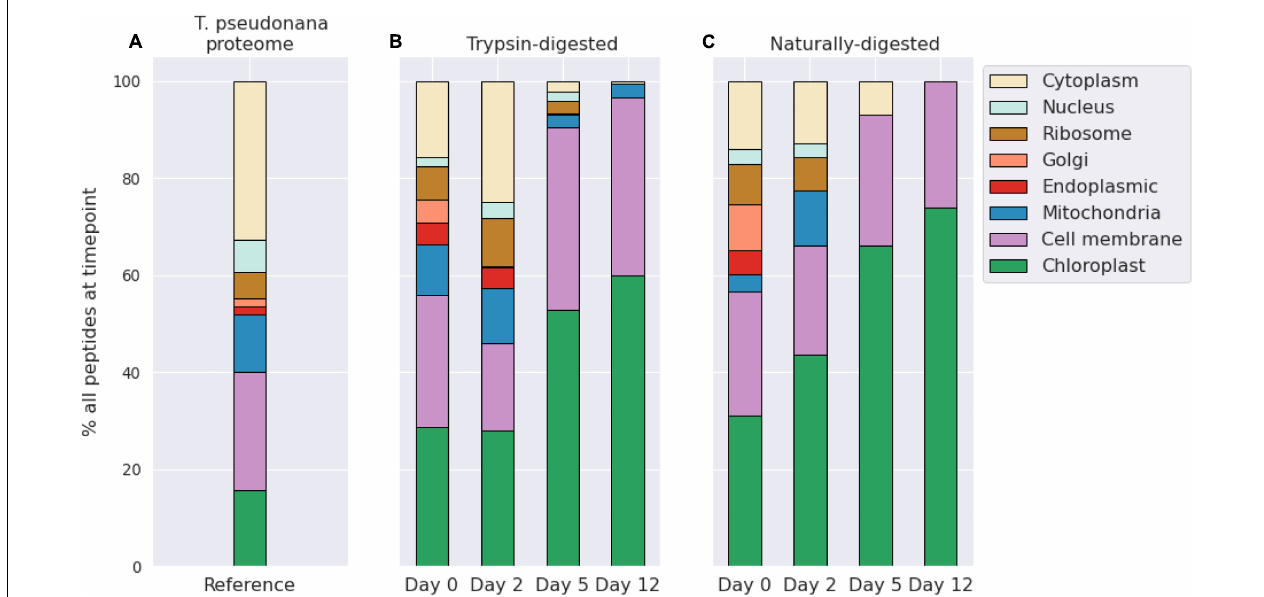
FIGURE 2 | Bar plots showing the distribution of diatom peptides from different cellular compartments over a 12-day degradation experiment, as determined by peptide gene ontology (GO) terms annotations. Peptide distributions are shown as overall percentages of peptides for each timepoint and for the reference proteome. Shown as context are peptides identified in a proteome of Thalassiosira pseudonana cultures from Dyhrman et al. (2012) (A) . Trypsin-digested (B) and naturally digested fractions (digestion only by natural microbial community, (C) are shown separately. Numbers of peptides at each timepoint and treatment are shown in Table 1 . GO terms shown were condensed from a broader set to eliminate redundancy for ease of visualization using REViGO (http://revigo.irb.hr/) and further manually organized into broad